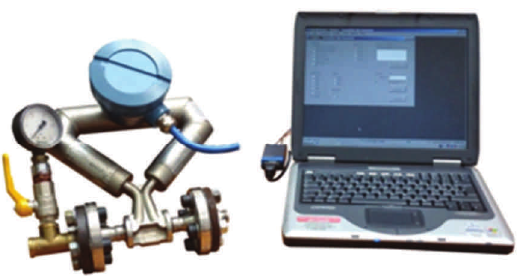
Fig. 5. CMF 025M Mass Flow Meter From Emerson Fig. 6 shows Yokogawa WT 1800E Power Analyzer.